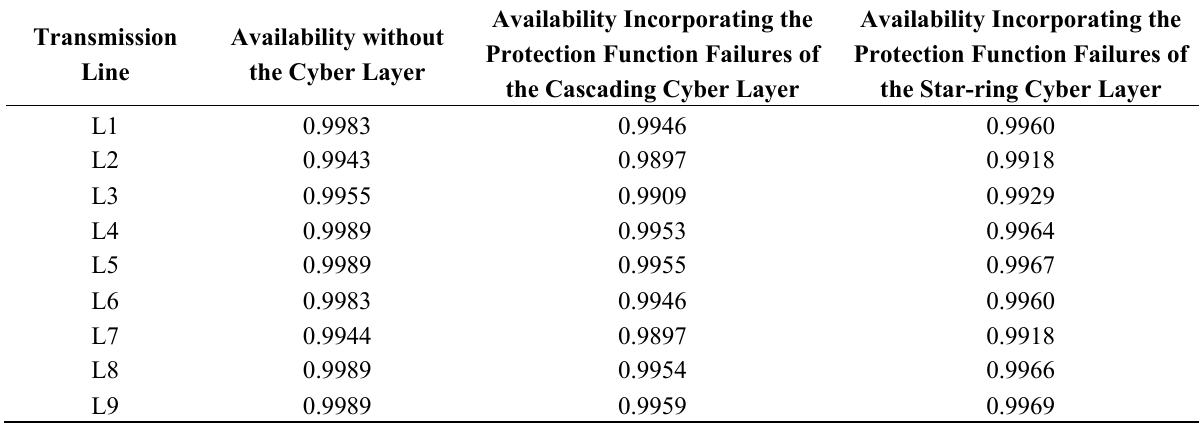
Table 3. The availability of transmission lines incorporating the protection function